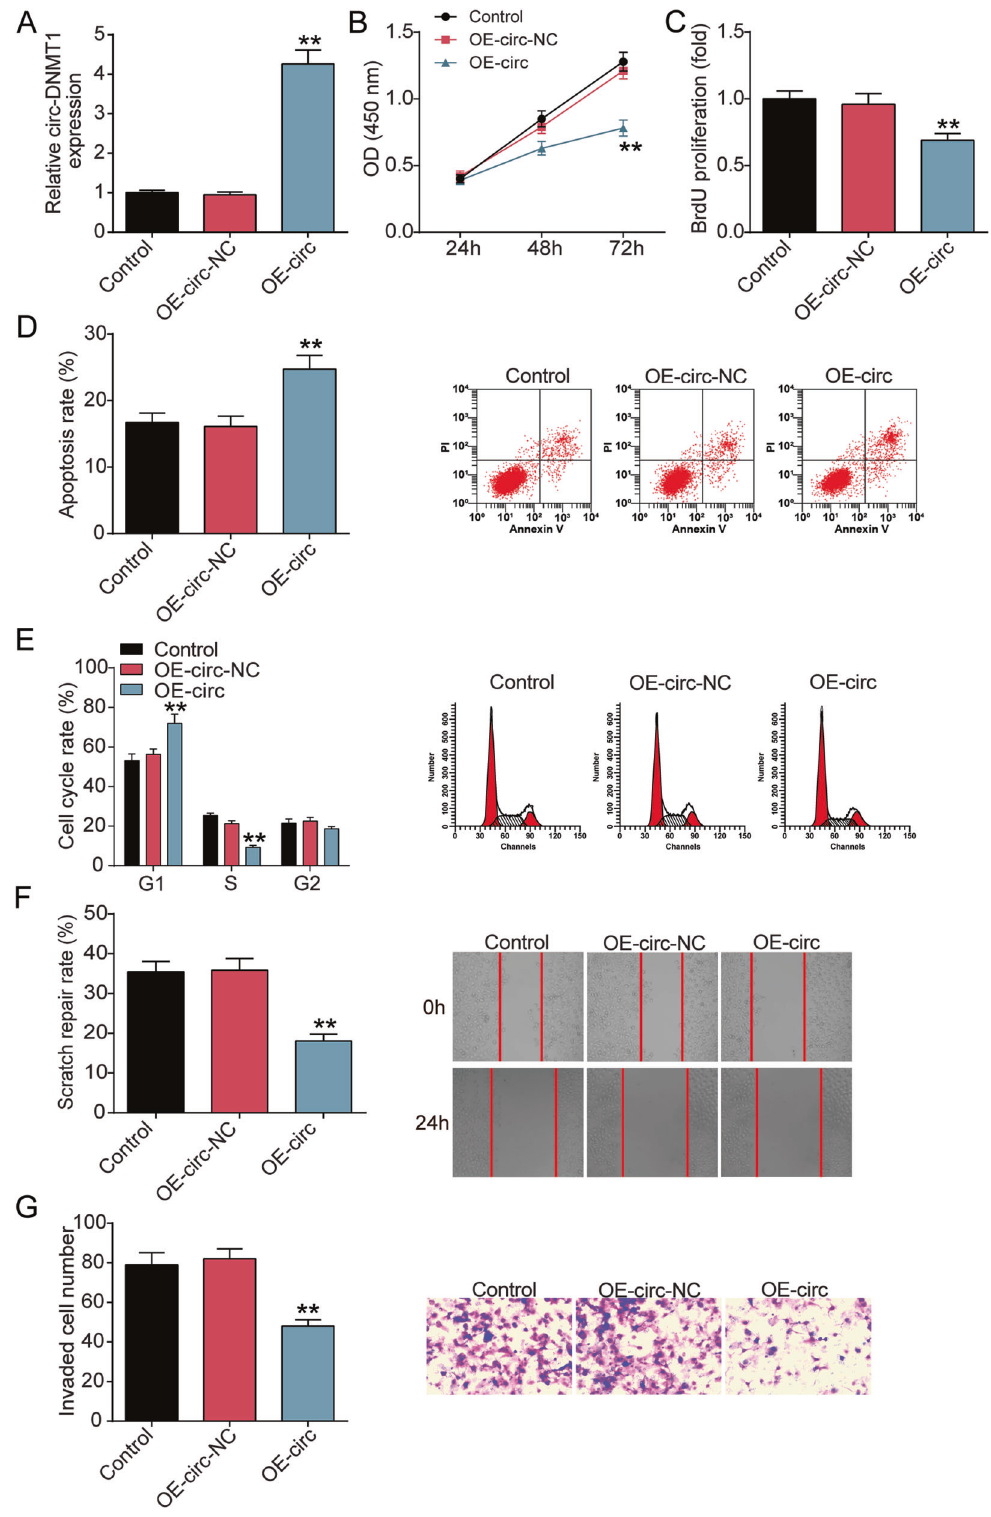
Fig. 3 Upregulation of circ-DMNT1 inhibits trophoblast cell survival. A HTR-8/SVneo cells were transiently transfected with circ-DMNT1 pcDNA3.1 (OE-circ) for 48 h. qRT-PCR analysis upregulated expression of circ-DMNT1. B CCK-8 assays were implemented to detect the viability of OE-circ-treated HTR-8/SVneo cells. C BrdU assays were implemented to detect the proliferation of OE-circ-treated HTR-8/SVneo cells. D The apoptotic rates of HTR-8/SVne cells transfected with OE-circ were measured by fl ow cytometry. E The cell cycle of HTR-8/SVne cells transfected with OE-circ was measured by fl ow cytometry. F Wound scratch assay was performed to detect the role of circ-DMNT1 on OE-circ-treated HTR- 8/SVne cell migration in vitro. G Transwell assays were performed to detect the invasion of HTR-8/SVne cells transfected with OE-circ. ** P < 0.001 compared with OE-circ-NC. N = 3, repetition =